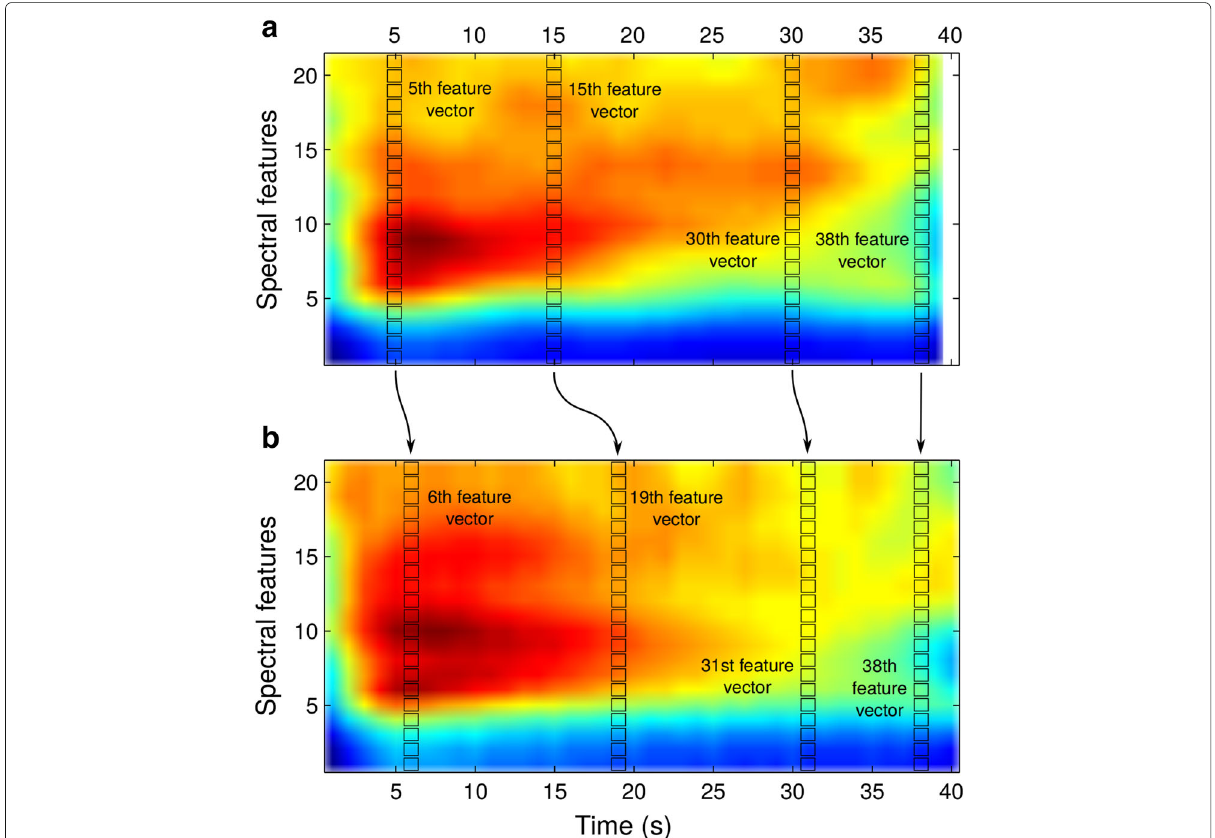
Fig. 1 Alignment by classical DTW of spectral features extracted from the triphone b-aa+dx as uttered by a male speaker mrfk0 and b by female speaker fdml0 in the TIMIT